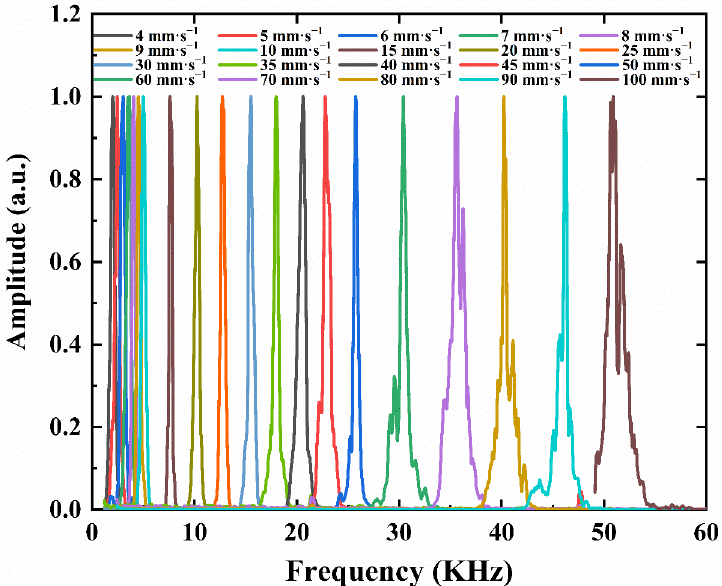
Figure 5. Frequency shift wave packet of the backscattering light when the velocity of the slide rail changes from 4 mm·s −1 to 100 mm·s −1 .